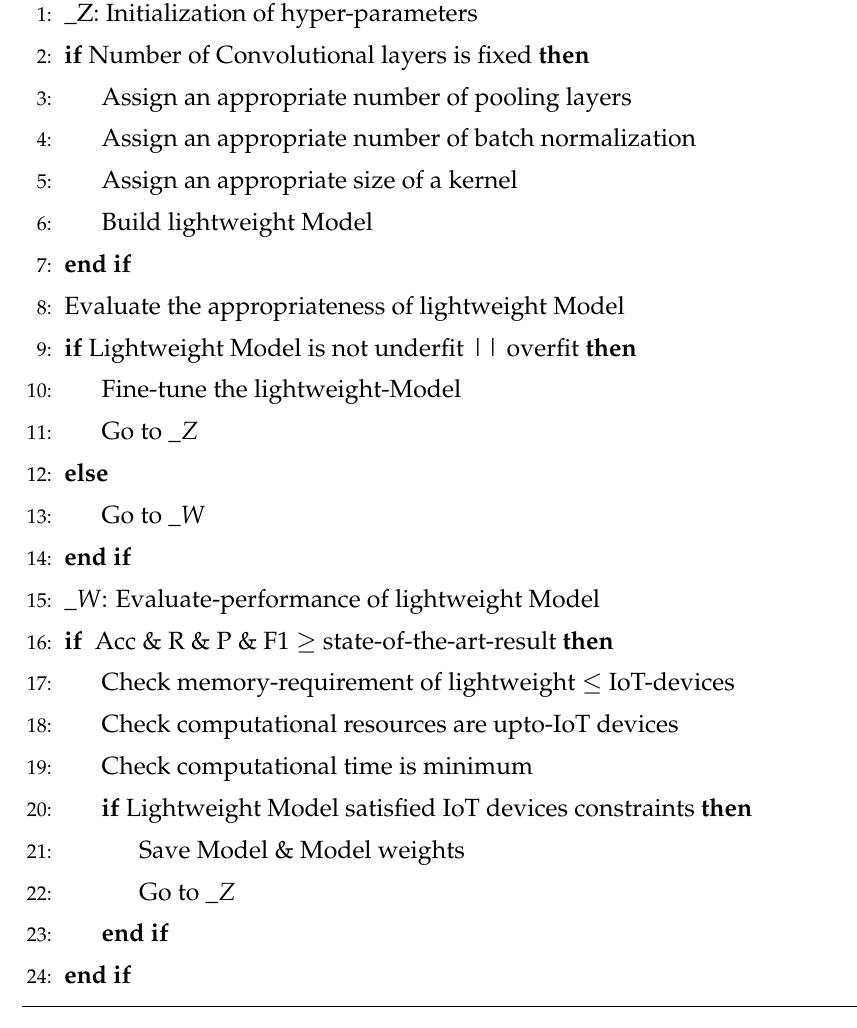
Algorithm 3 Designing a constraint-based lightweight model for IoT